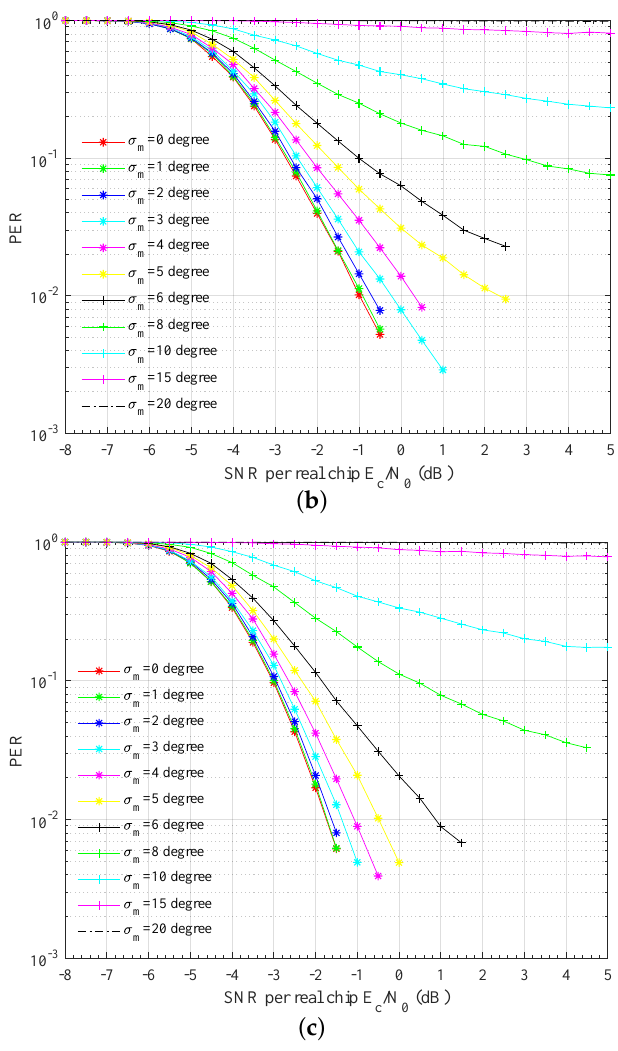
Figure 8. Detection performance comparisons of our proposed scheme versus carrier frequency offsets (CFOs) over a pure AWGN channel. ( a ) PER performance with full estimator in (16); ( b ) PER performance with simplified estimator in (18); ( c ) PER performance with simplified estimator in